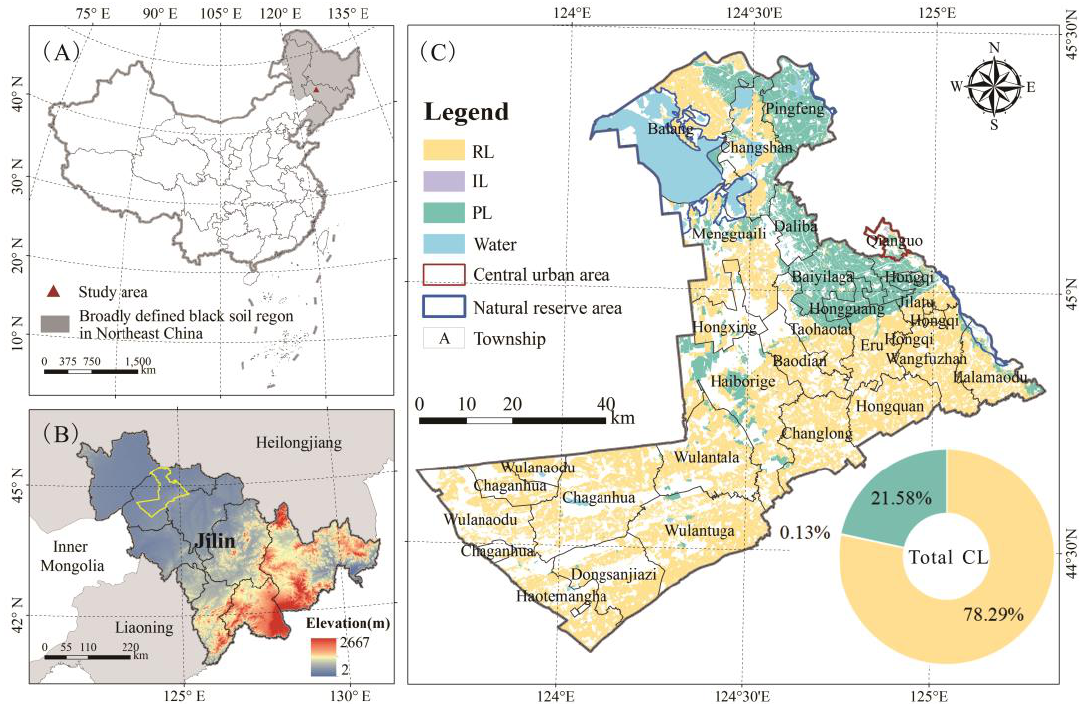
Figure 4. Location and spatial distribution of CL in Qianguo County (A. The distribution of the broadly defined black soil region in the Northeast China; B. The topographic map of Jilin Province and the location of the study area; C. The distribution of cultivated land resources in Qianguo County).